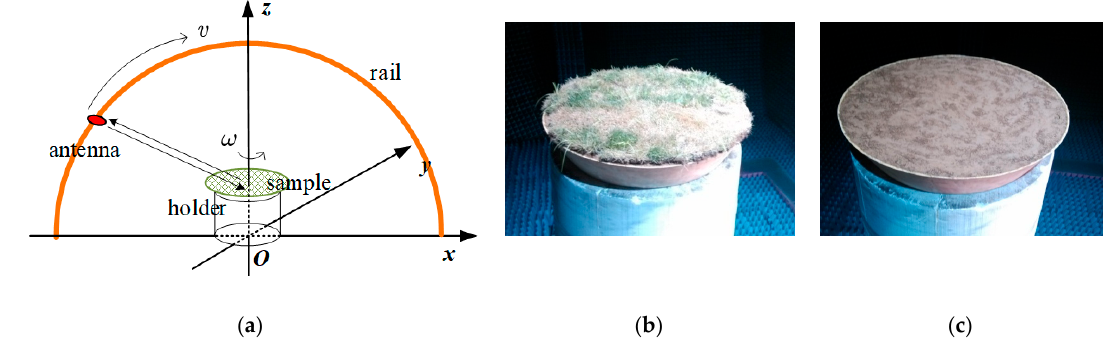
Figure 4. ( a ) The schematic diagram of measurement set-up; ( b ) the grass sample; ( c ) the concrete sample.